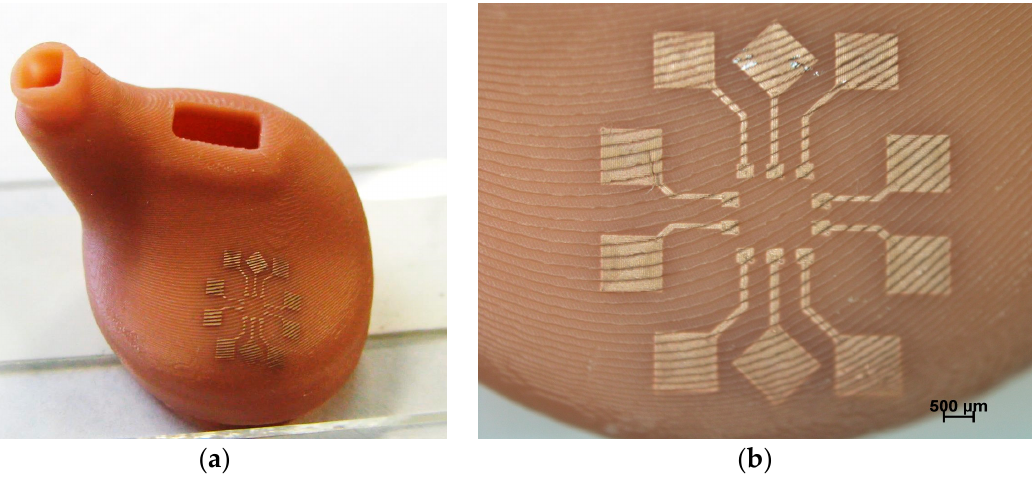
Figure 3. Aerosol jet printed Ag structures (ink: Sicrys I30 EG-1) on 3D ear mold substrate (Fototec